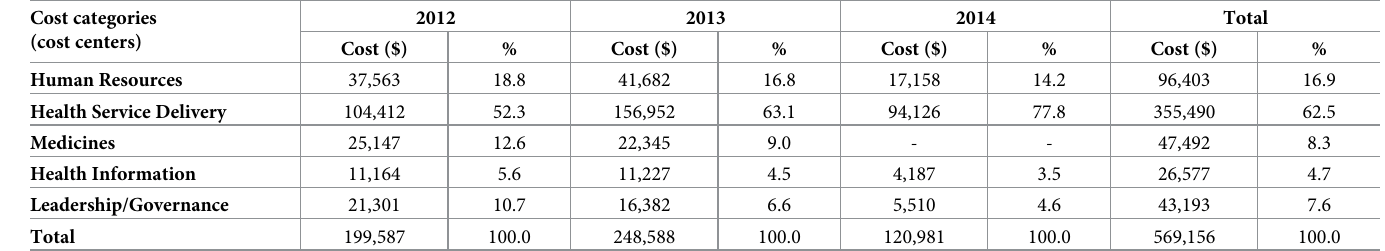
Table 4. Financial cost of GEHIP by health system building blocks.